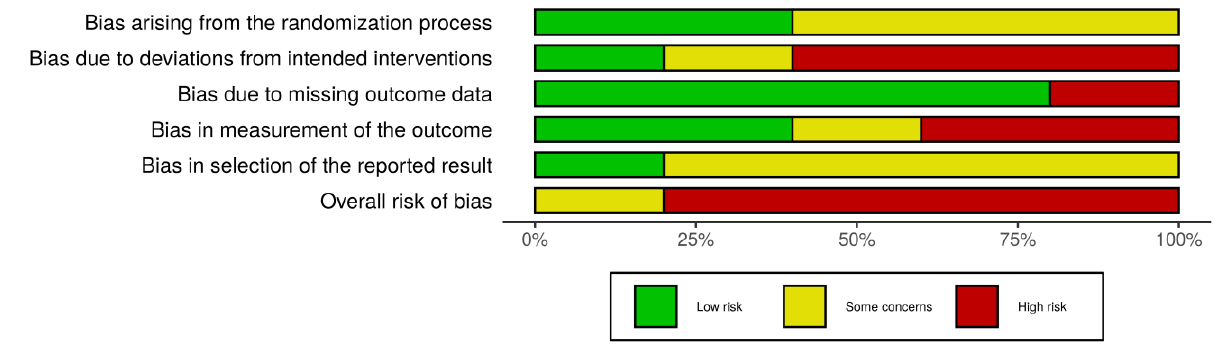
Figure 3. Risk of bias diagram for RCTs.